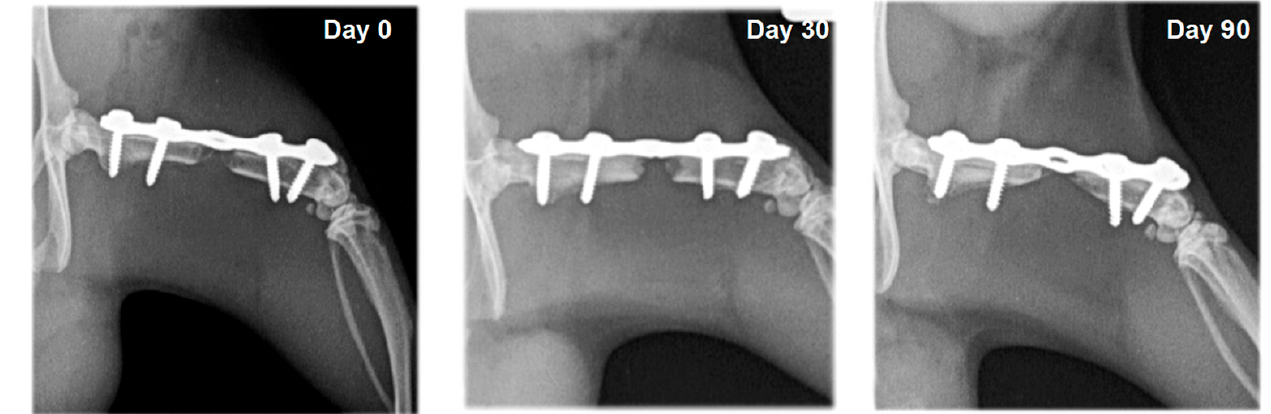
Figure 4. Serial craniocaudal radiographs of rat femurs from experimental group F2 on post-operative days 0, 30 and 90.